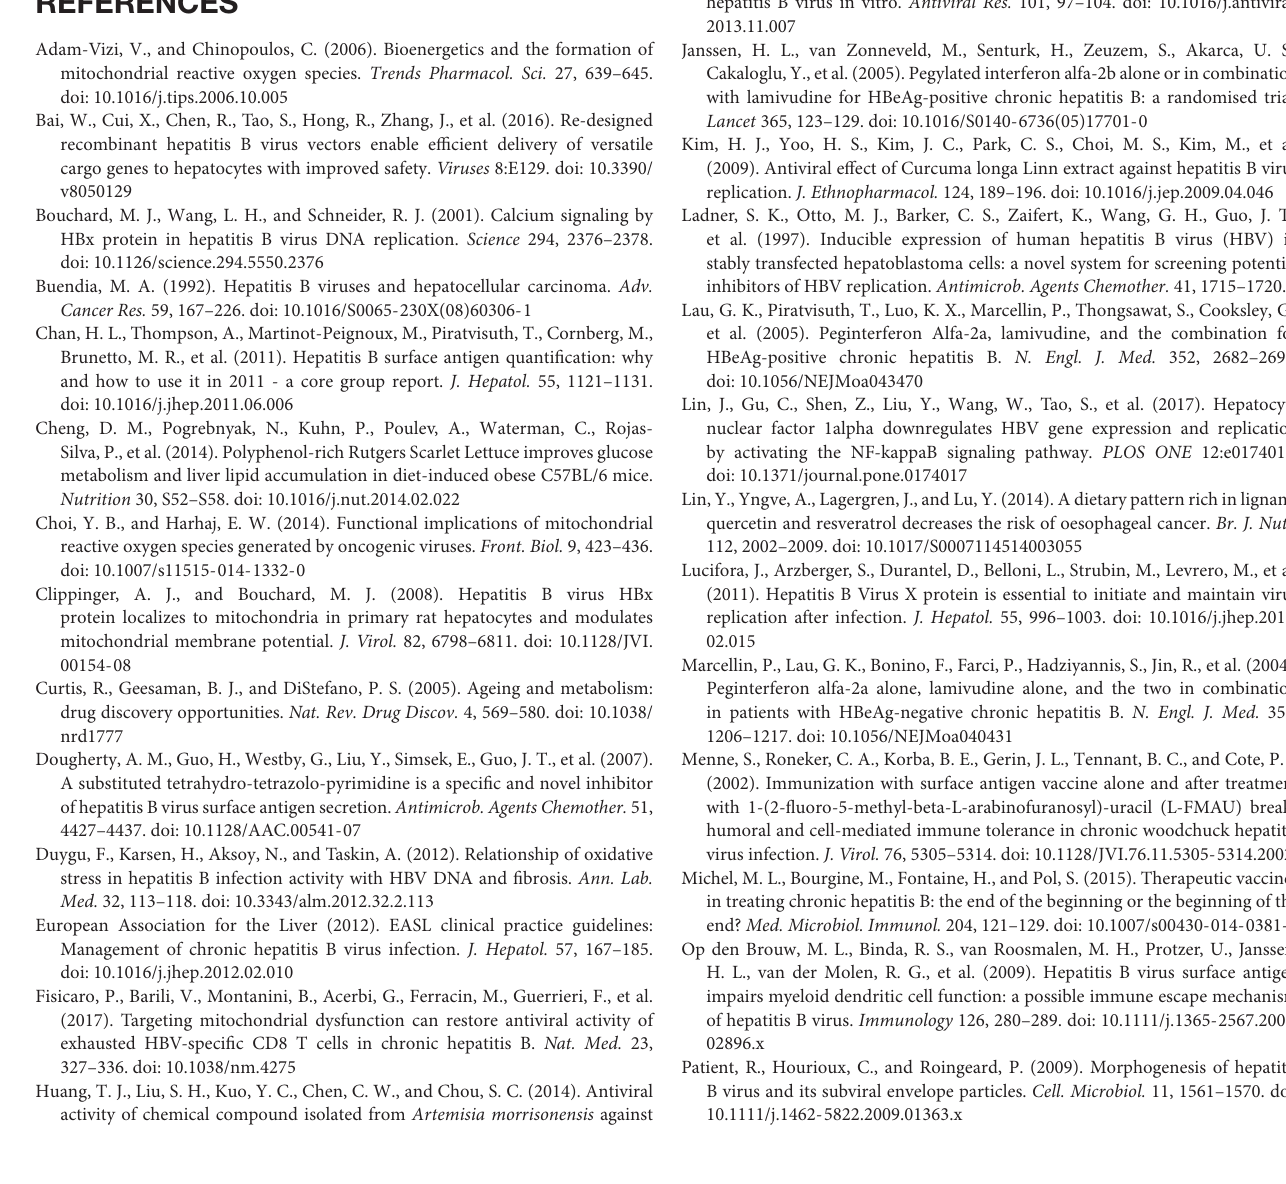
FIGURE S1 | Cytotoxicity of lettuce extracts and differential metabolites in HepG2.2.15 cells. (A) Represented the morphology of normal cells and (B) represented the morphology of the cells that treated with luteolin-7- O -glucoside. A large number of vacuoles were observed in cells treated with quercetin-3-(6 (cid:48)(cid:48) -malonylglucoside) (C) , chicoric acid (D) and chlorogenic acid (E) at the concentrations. The CCK8 assay provided consistent results as the morphological analysis (F) . Semi-quantitative analysis of HBsAg and validation of the HBsAg ELISA standard curve using a commercial quantitative assays (G) . Statistical significance was calculated using student’s t -test. Ns, not significant, ∗ P < 0.05, ∗∗ P < 0.005, ∗∗∗ P < 0.0005, ∗∗∗∗ P < 0.0001. FIGURE S2 | The effects of different concentrations of IFN α -2b on HBV replication and transcription in HepG2.2.15 cell line. HBV replication intermediates were extracted and detected by Southern blot hybridization (A) and quantified using fluorescence quantitative PCR (B) . Viral RNAs were examined by Northern blot (C) and quantified using fluorescence quantitative PCR (D) . All values are expressed as percentages relative to the untreated control. RC, relaxed circular